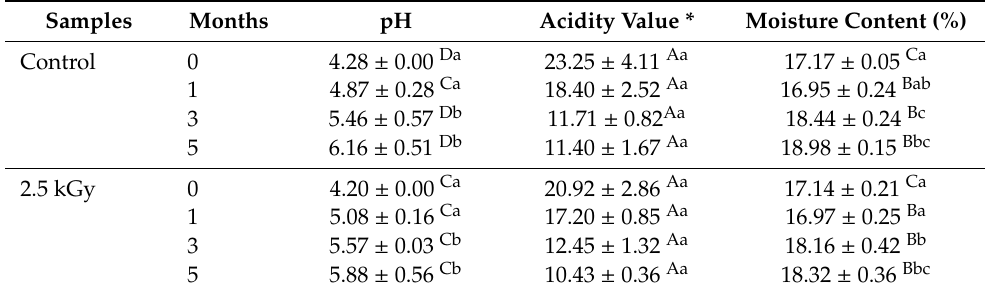
Table 1. The pH, acidity degree * and moisture content changes during the storage of irradiated and control tarhana samples.